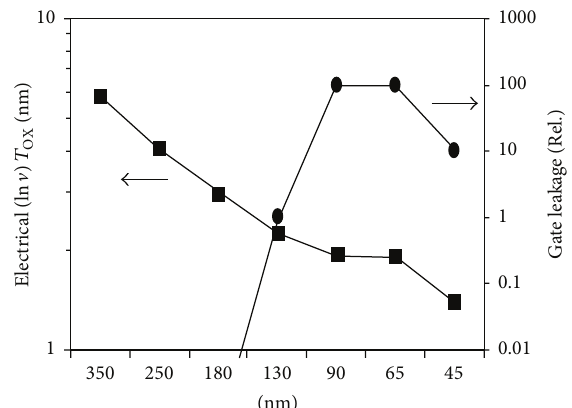
Figure 4: Effect of 𝑇 OX scaling and gate leakage versus Intel technology [10].